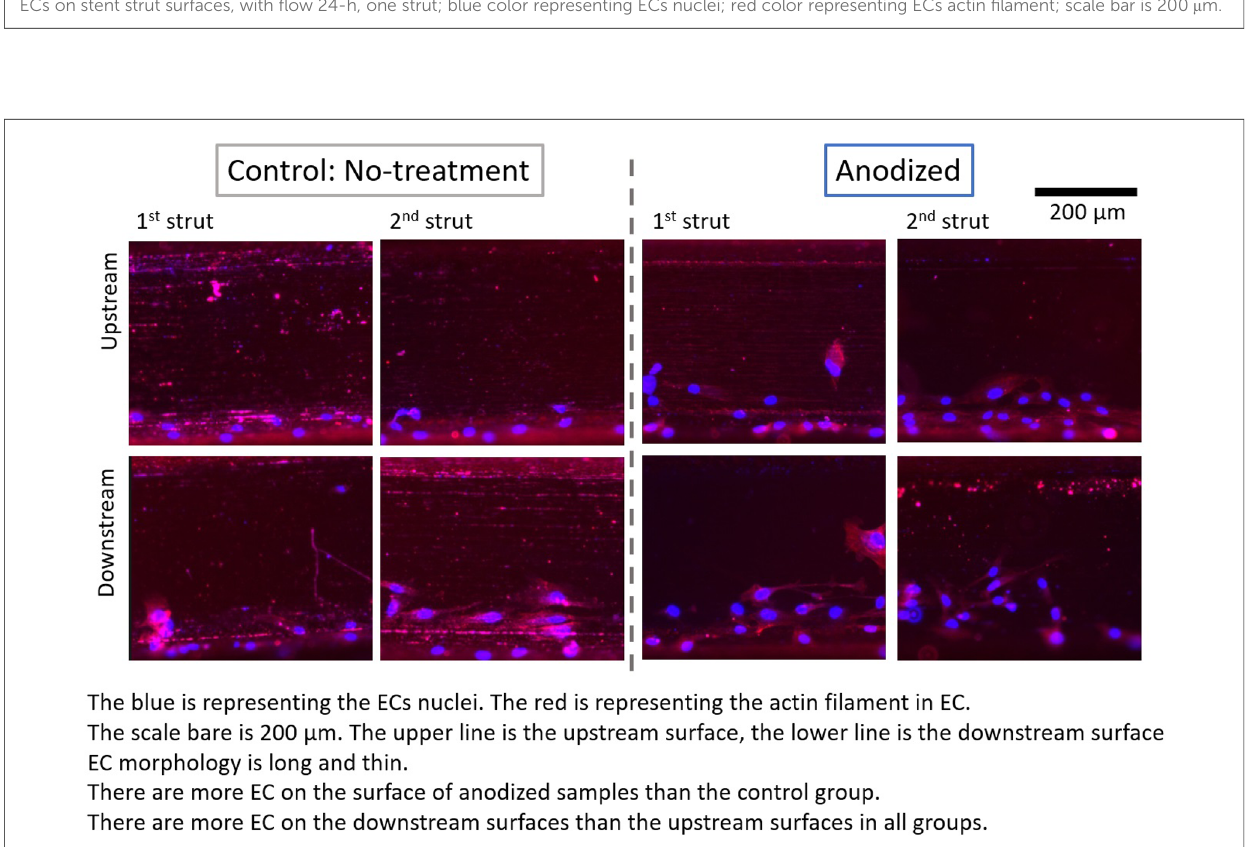
FIGURE 6 ECs on stent strut surfaces, with fl ow 24-h, two struts; blue color representing ECs nuclei; red color representing ECs actin fi lament; scale bar is 200 μ